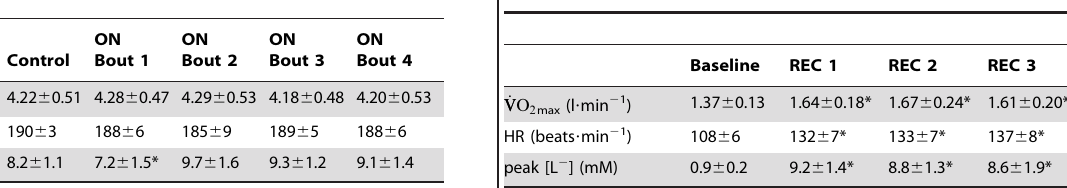
Table 3. _ VVO 2 max , HR and [L 2 ] attained at the pre-exercise baseline, and in the 4 min recovery bouts during the maximal HIIT